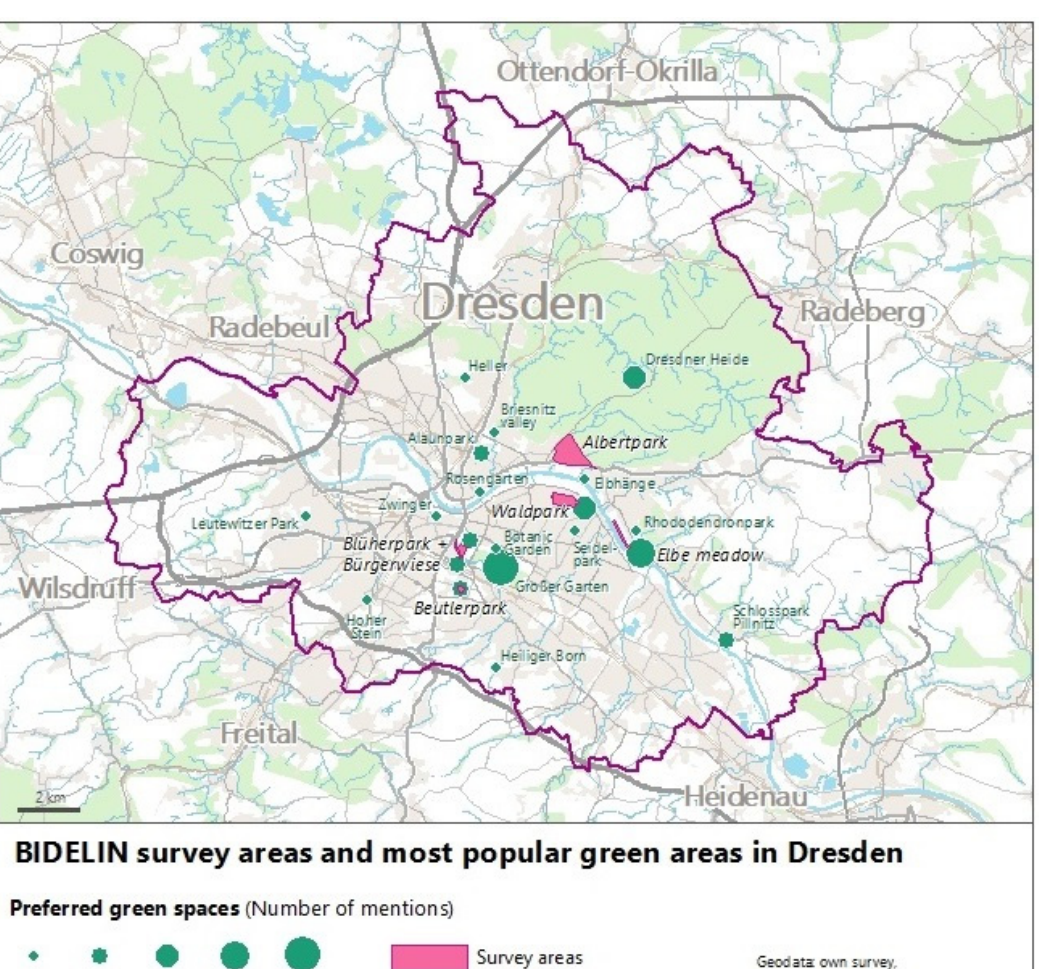
Figure 2. Dresden, view across the River Elbe to the survey location Loschwitz Elbe meadows (photo: R.-U. Syrbe).